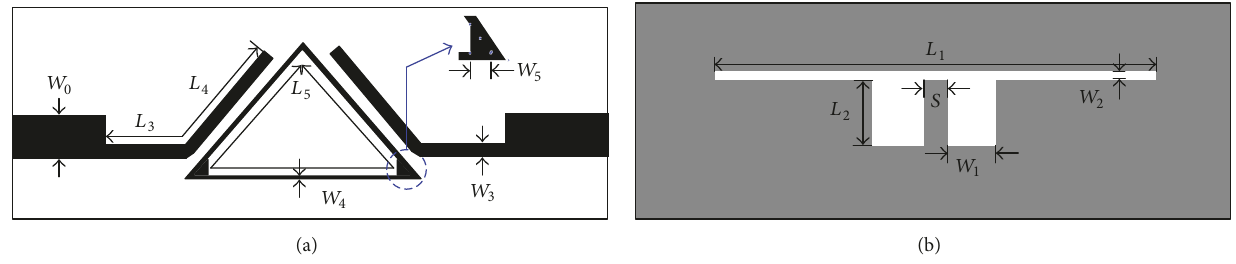
Figure 7: Schematic of the proposed filter. (a) Top layer and (b) bottom